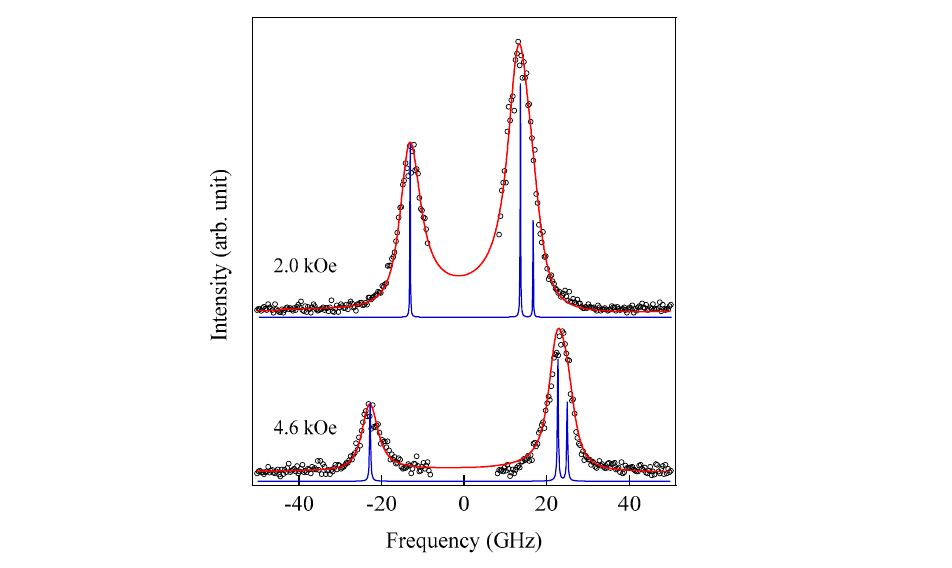
Figure 34. Comparison of BLS spectra observed from the x (Co) = 50.3 SPM film at H = 2.0 and 4.6 kOe. The solid lines on the observed spectra ( ○ ) give the numerical fits obtained via the CM theory. To show the singlet‑doublet structures, the calculated response function S ( Q // , ω ) with small damping of 0.1 ≤ Γ /2 π ≤ 0.15 GHz is indicated by the solid lines